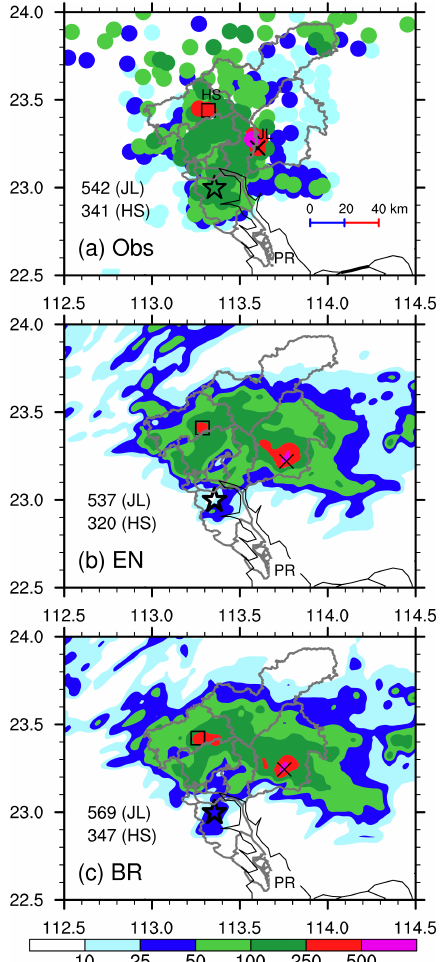
Figure 3. Spatial distribution of the 18h accumulated rainfall dur- ing the period of 20:00BST 6 May to 14:00BST 7 May 2017: (a) rain gauge observations and (b–c) simulations with the EN and BR autoconversion schemes. A cross sign ( × ) and a square sign ( (cid:3) ) denote the locations where maximum hourly rainfall rates were (a) observed or (b–c) simulated near Jiulong (JL) and Huashan (HS), respectively. The values marked with JL and HS indicate the 18h maximum accumulated rainfall amounts near JL and HS, re- spectively. A star indicates the city centre of Guangzhou, and the Pearl River is marked by PR. This notation is used for the rest of the